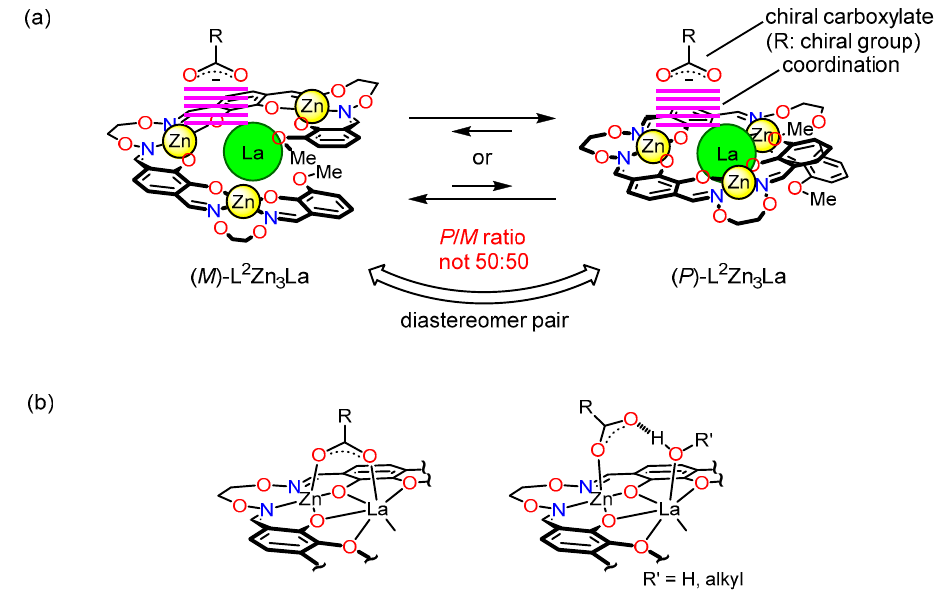
Figure 7. ( a ) Helicity control of L 2 Zn 3 La by coordination of chiral carboxylate ions (Category B in Figure 4). ( b ) Two major coordination modes of carboxylate ions to the Zn–La core found in crystal structures of related complexes.